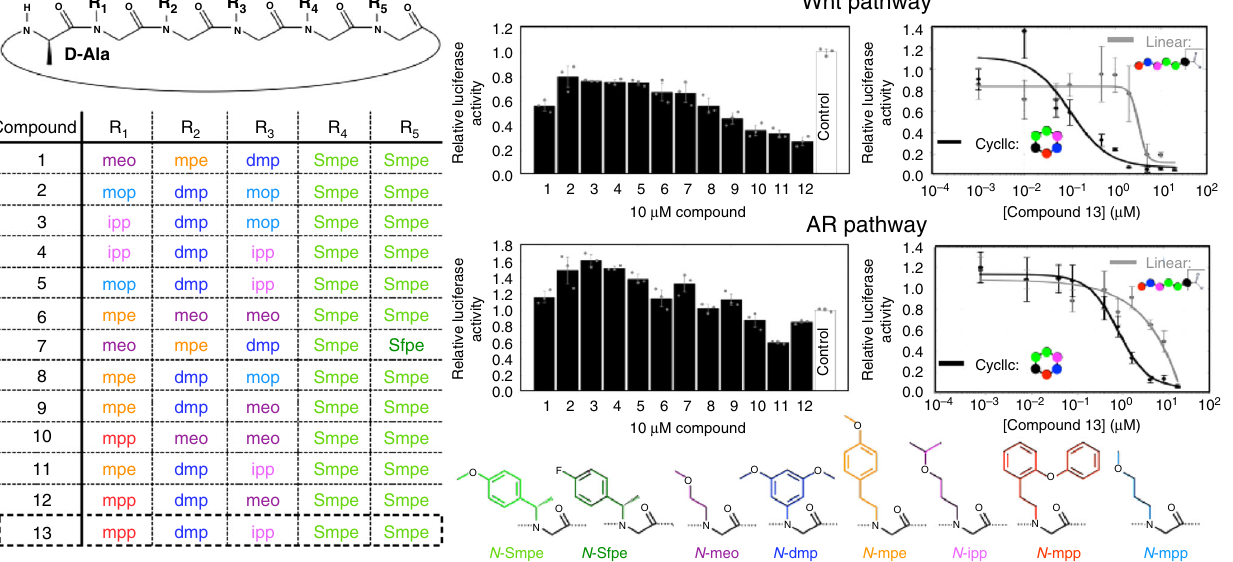
design suite 51 . The in silico Δ G binding values were evaluated after several iterations of guided (The PyMOL Molecular Graphics